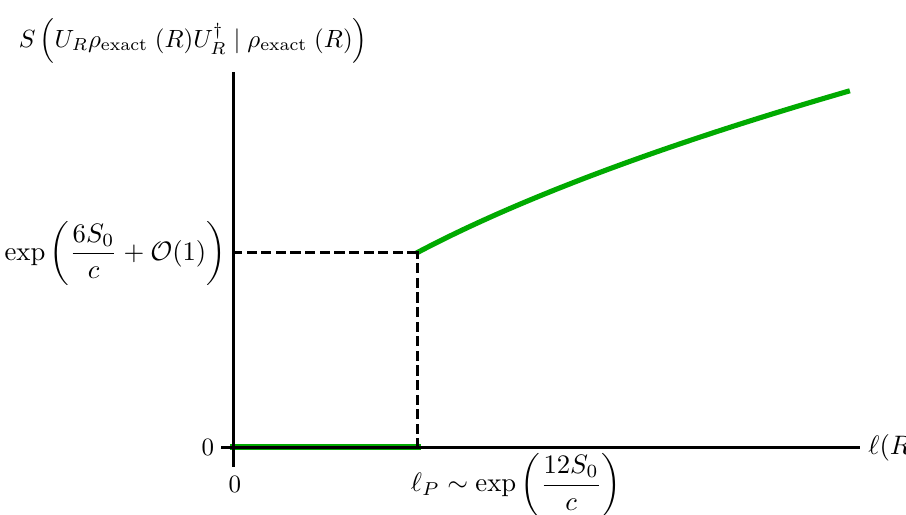
Figure 2 . The relative entropy in the free fermion model, as a function of the size of the region R at fixed non-zero α . The horizontal axis is ‘ ( R ) the length of R in units of φ r /c ( ‘ ( R ) ≡ c ( b 2 − a 2 ) /φ r ≈ cb 2 /φ r ). In the semi-classical approximation, there is a discontinuity in the relative entropy at the “Page length” ‘ P ( R ) ∼ e 12 S 0 /c when an island appears in the gravity region, see (2.24). It might seem that the relative entropy is large because it has S 0 in the exponential, but recall that in this model the ratio S 0 /c is kept finite and not very large [28], so the relative entropy is O (1) . √ We see that (2.21) diverges as 1 / 1 − η when η → 1 , where the island and the bath